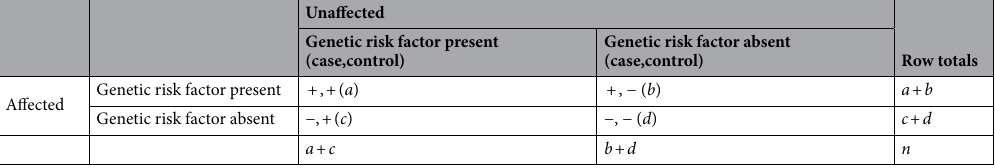
totalsGenetic risk factor present